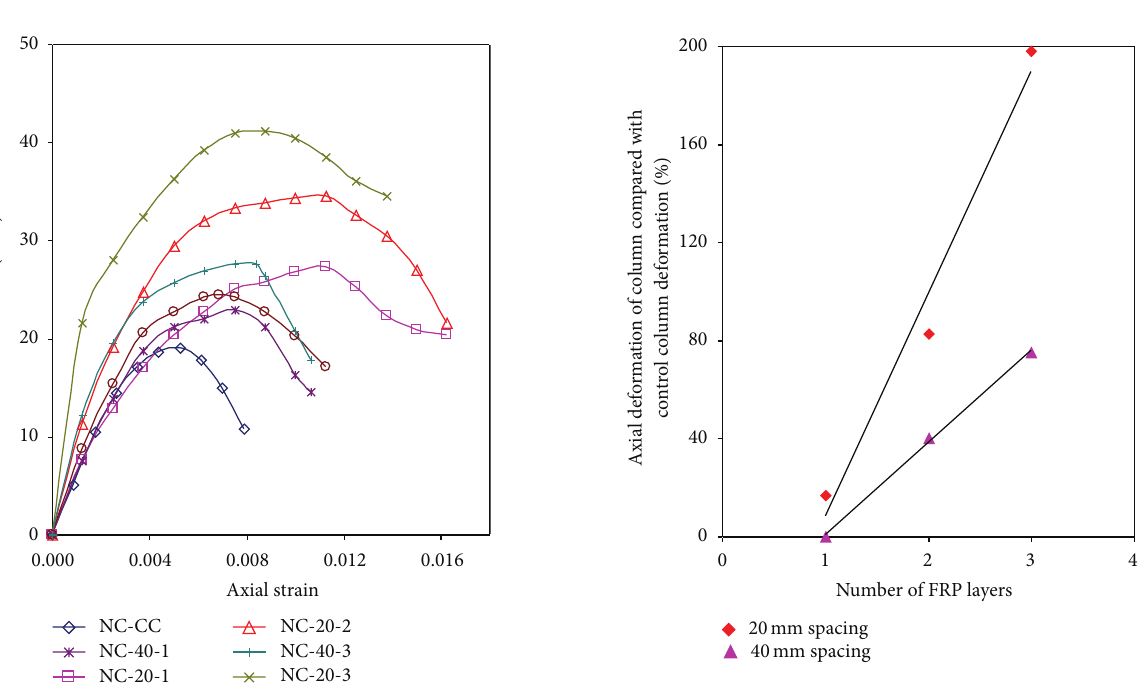
Figure 15: Relation between axial deformation control and number of CFRP